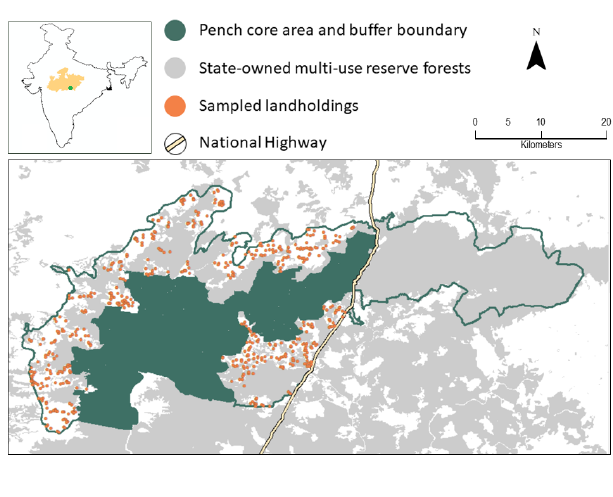
Fig. 2. Map of the Pench Tiger Reserve (PTR), delineating the core area and the buffer area. The farmer surveys (n = 602) were conducted in 500 km² of buffer area to the west of the national highway. Surveys were distributed uniformly across the four administrative ranges and in proportion to village population. Inset: location of PTR in the State of Madhya Pradesh,